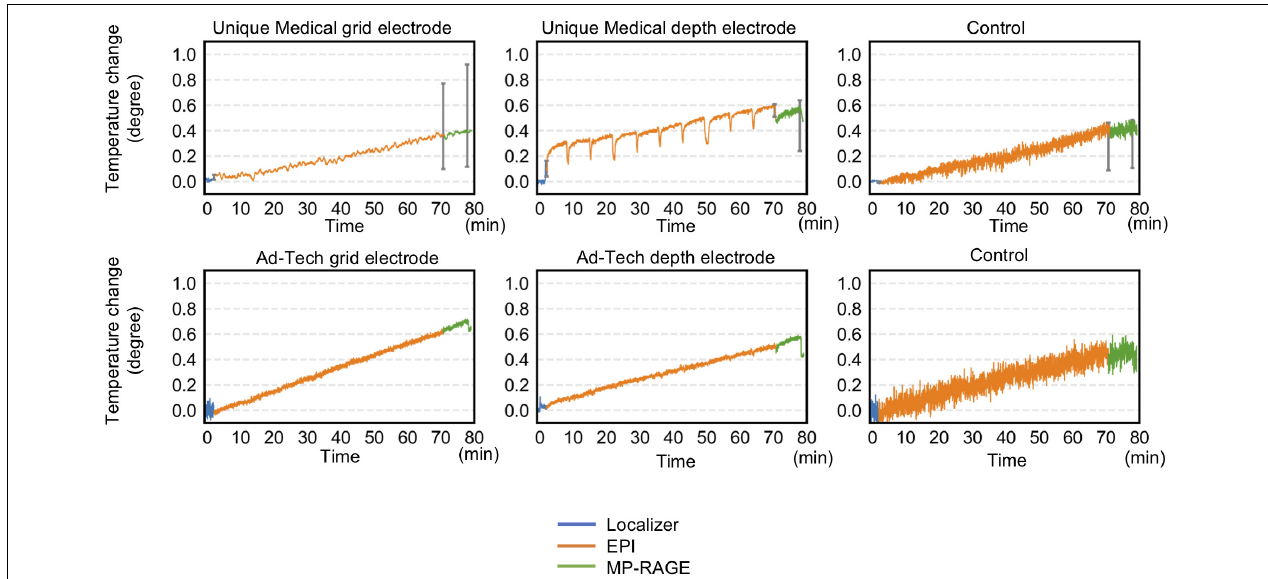
FIGURE 7 | Temperature changes throughout the 70-min acquisition using all sequences of a typical simultaneous acquisition of icEEG and fMRI experiment. Radio frequency-induced heating on grid and depth electrodes placed orthogonal to the static magnetic field were shown. For Unique Medical electrodes, each trace represents the median temperature changes from three measurements. Error bars show the interquartile range of the measured temperature at the end of each sequence. The total temperate increase was within 1 ◦ C regardless of electrode type. Compared to Ad-Tech, Unique Medical electrodes showed a more abrupt temperature decrease between